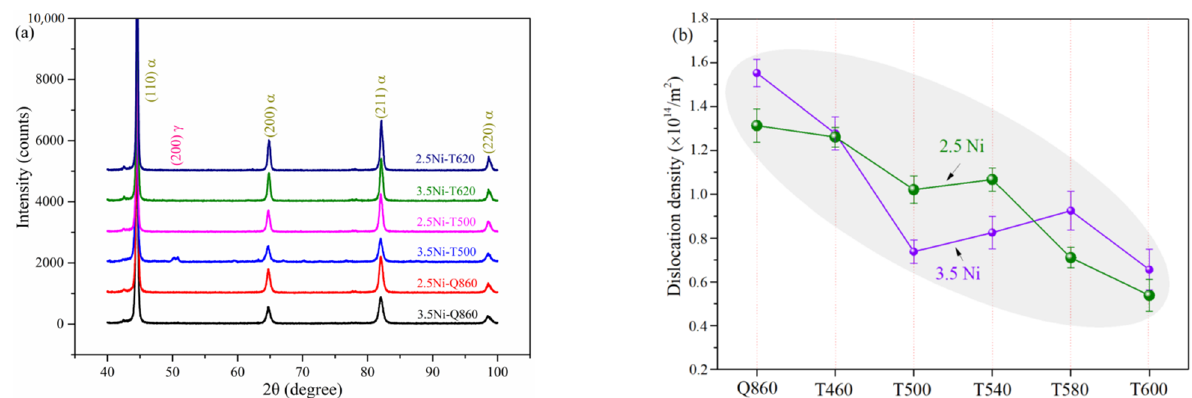
Figure 4. ( a ) XRD spectra. ( b ) The relationship between dislocation density and heat treatments process.